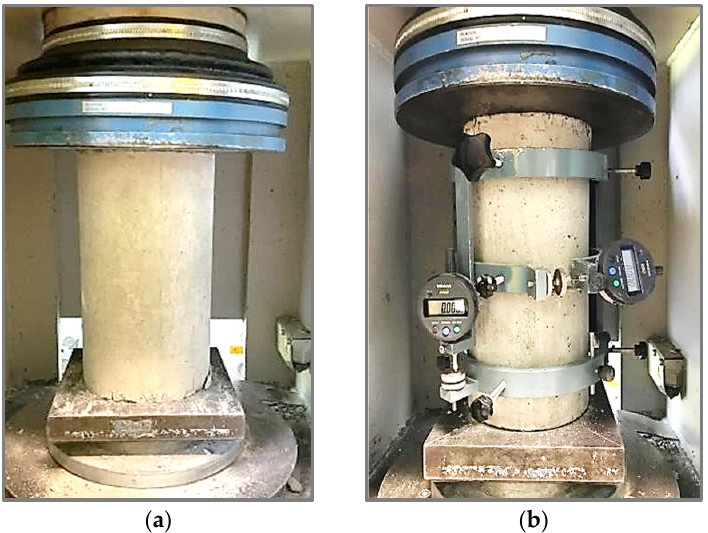
Figure 5. ( a ) Compressive strength test; ( b ) Modulus of elasticity and Poisson’s ratio test. Cylindrical samples of 300 mm by 150 mm were used to evaluate the elastic modulus and Poisson’s ratio of the OBA ‐ RECC, as required by ASTM C469 ‐ 02. As shown in Figure 5b, a compressometer (manufactured by Utest material testing equipment, Ankara, Tur ‐ key) was fitted to the sample on which two extensometers were attached for measuring the longitudinal and lateral strains to the closest 50 millionths accuracy. The setup was placed in the UTM and subjected to an axial compressive load three consecutive times seated. The specimen was then repeatedly loaded at a rate of 5.9 kN/s until 40% of its